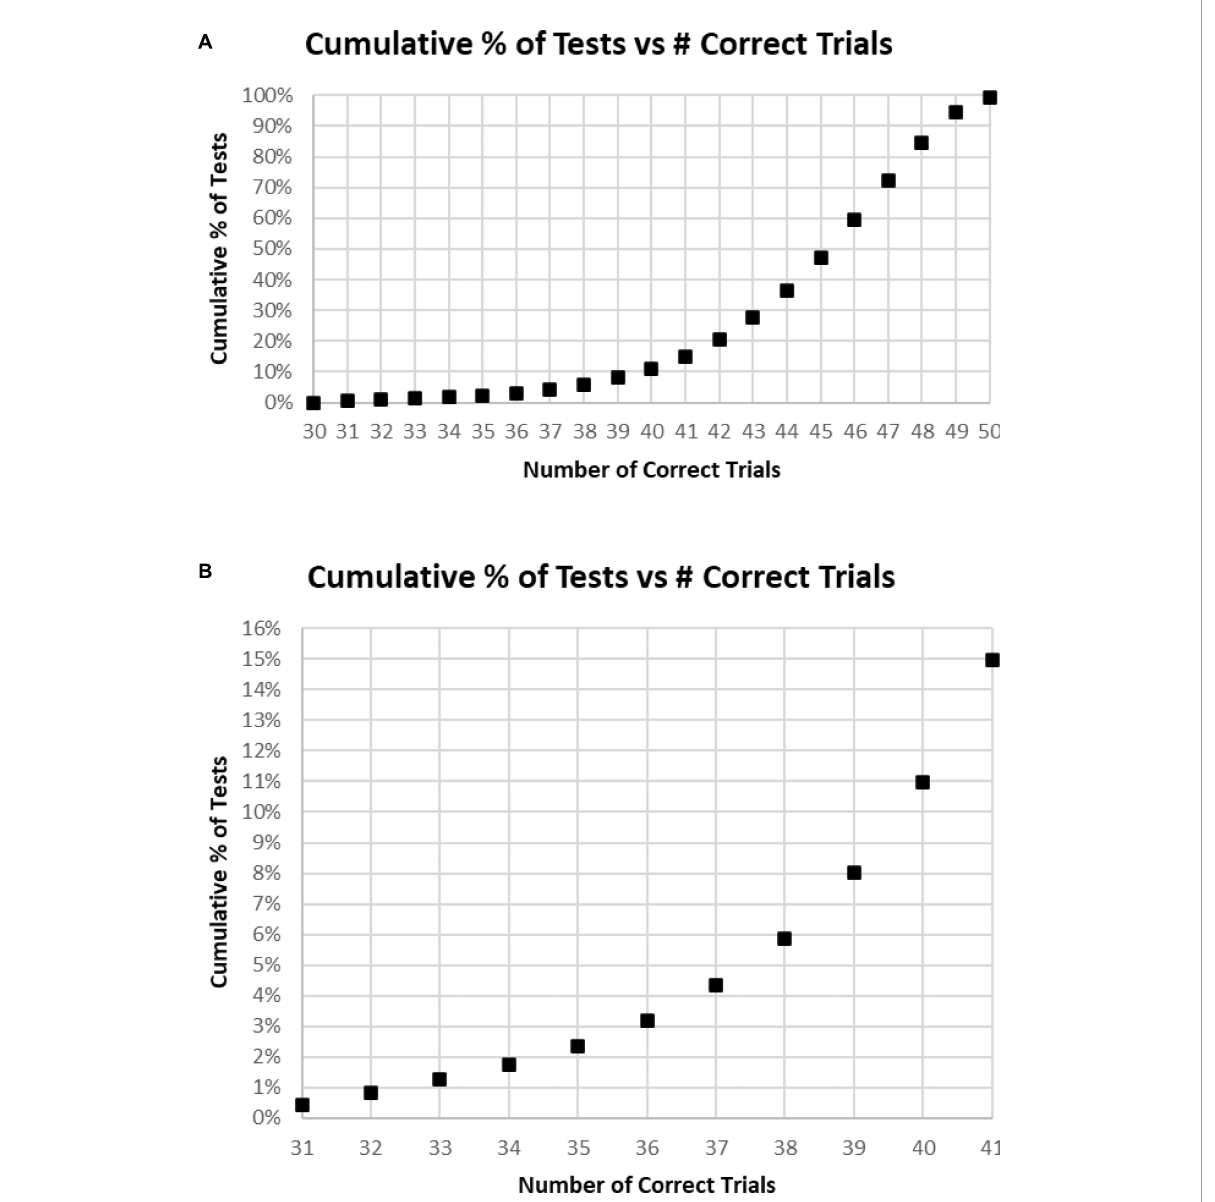
FIGURE4 (A) Cumulative percentage of tests from 30 correct (60%) to 50 correct (100%). (B) Higher resolution of (A) to show the percent of tests more precisely for number correct